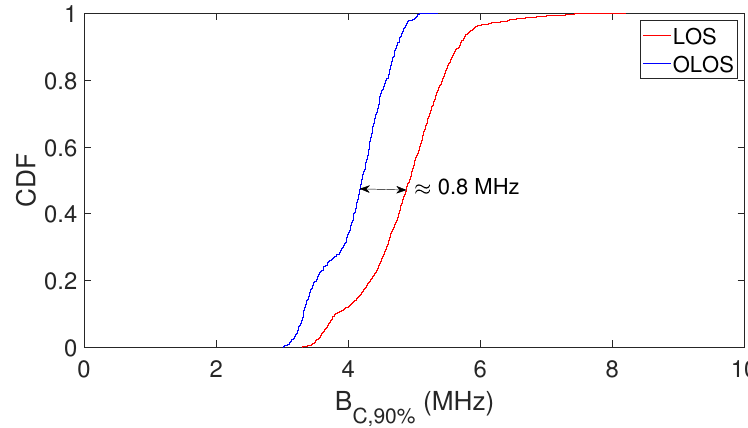
Figure 9. CDF of B C,90% for the LOS and OLOS scenarios.